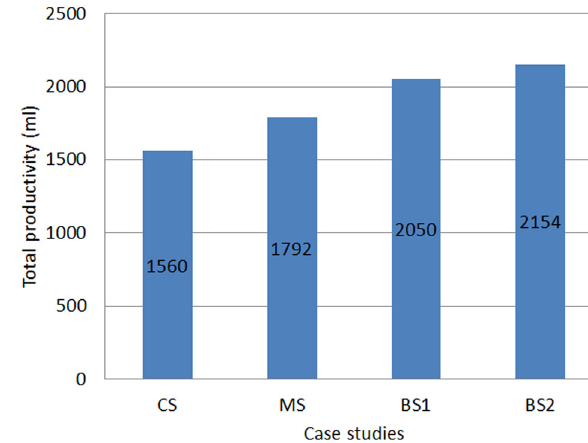
Figure 11: Variation of condenser inside surface temperatures with time.